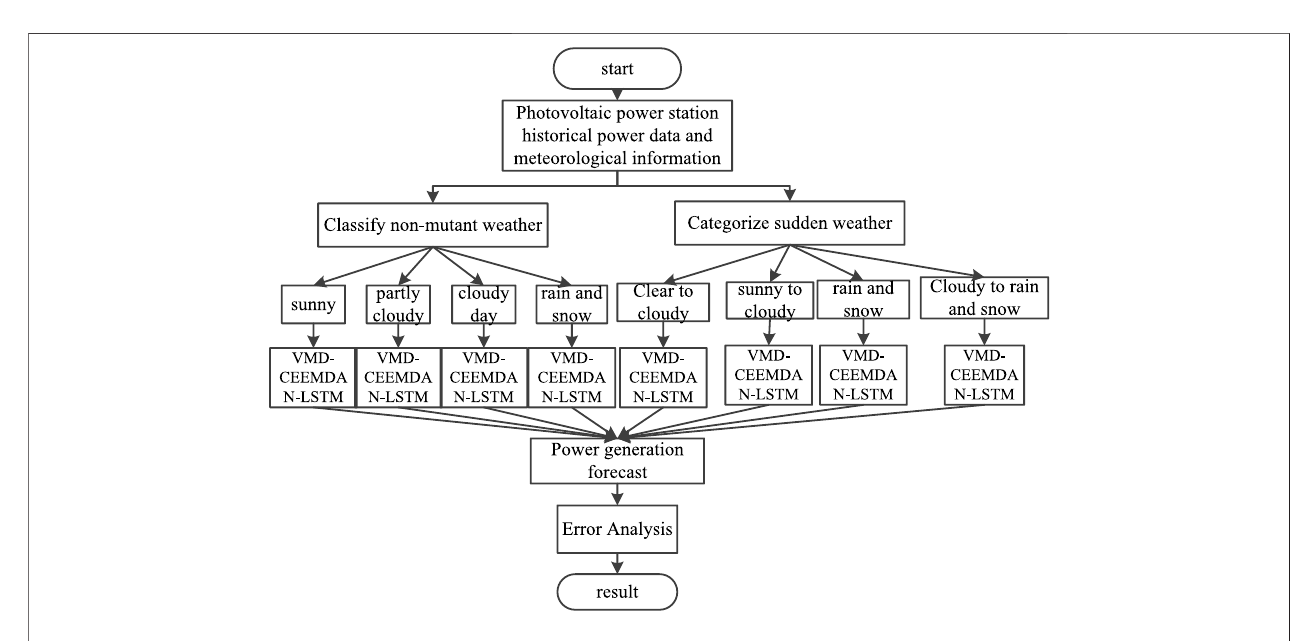
FIGURE 2 | Forecasting